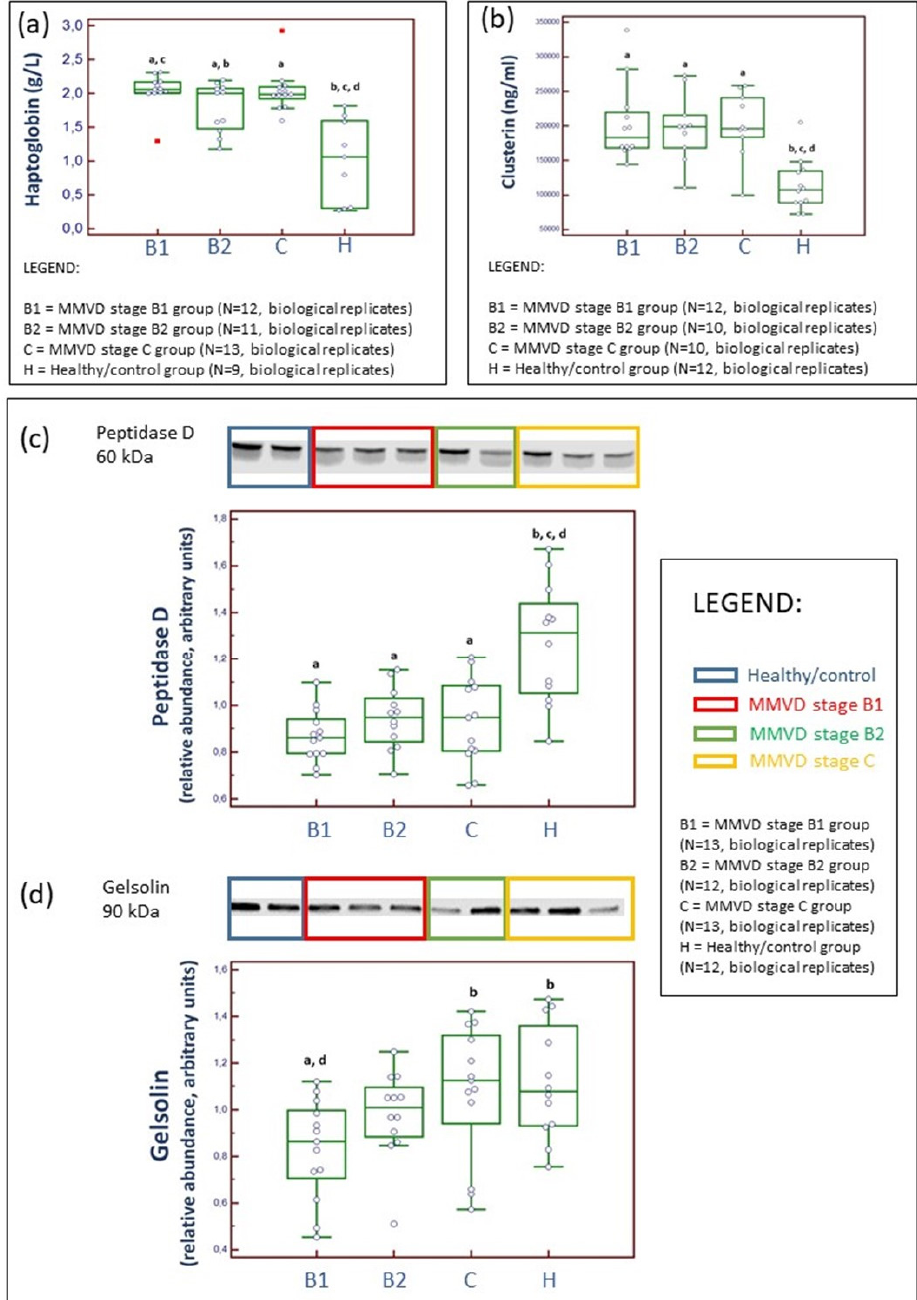
Figure 6. Analytical validation of proteomics results. Serum concentrations of haptoglobin (HP) measured by haptoglobin spectrophotometric assays ( a ) and clusterin assessed through an ELISA ( b